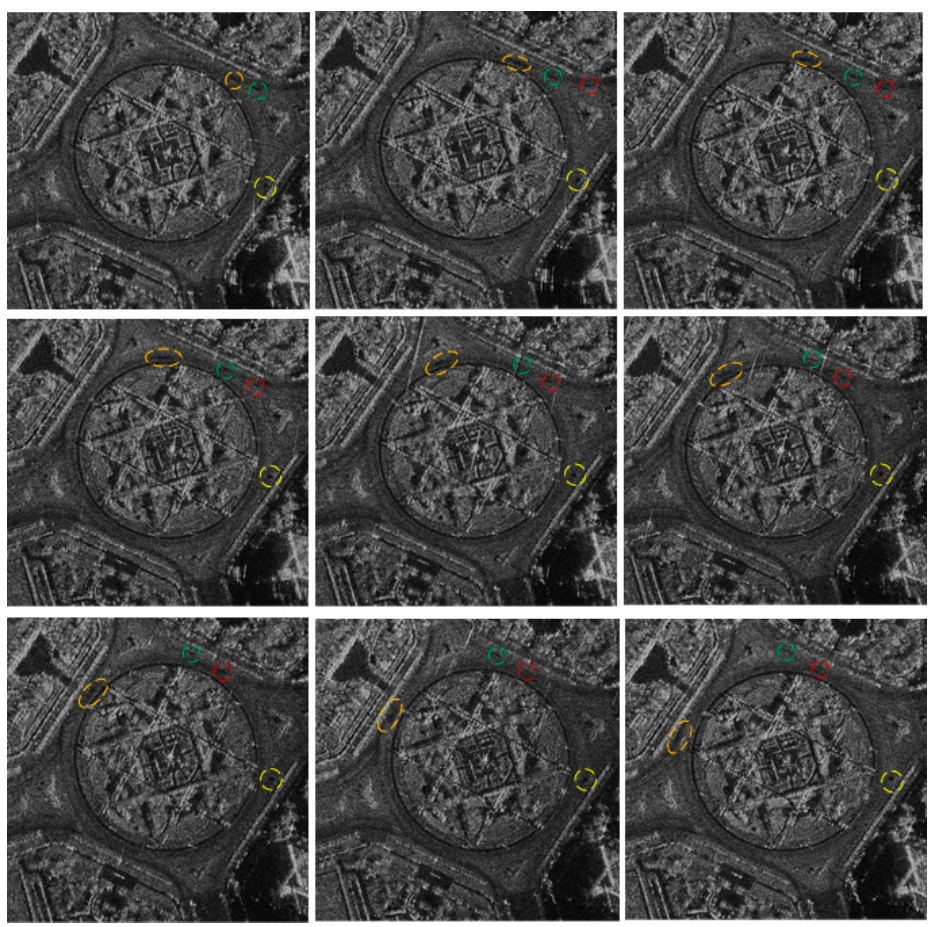
Figure 26. Tracking of moving cars on the ring